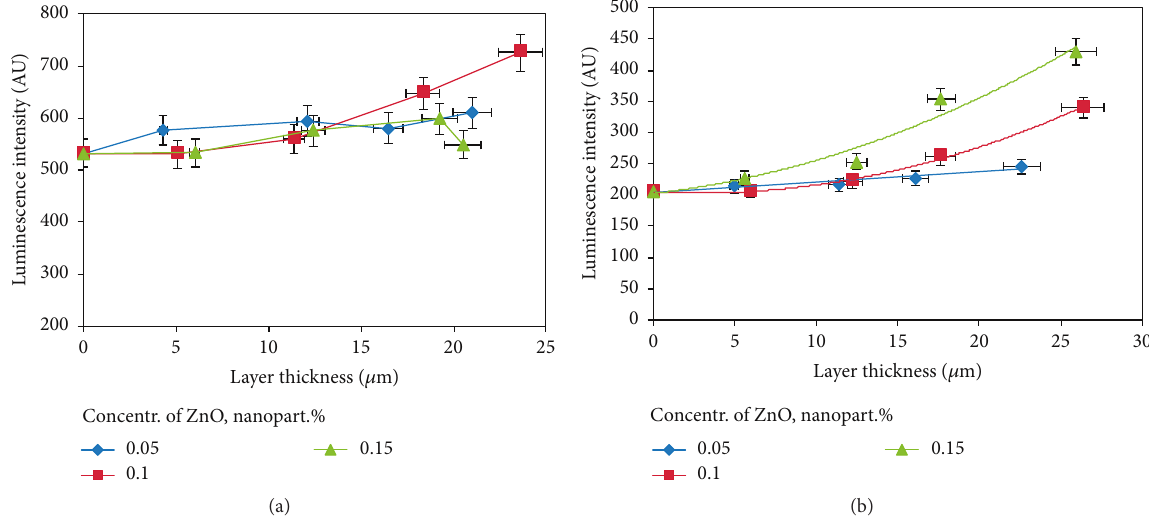
Figure 12: The dependency of the luminescence peak at 𝜆 = 430 (a) and 𝜆 = 520 nm (b) of printed impressions on paper with the maximum content of OBAs (paper 3), obtained using ink compositions with different contents of the fluorescent component (ZnO nanoparticles), on ink layer